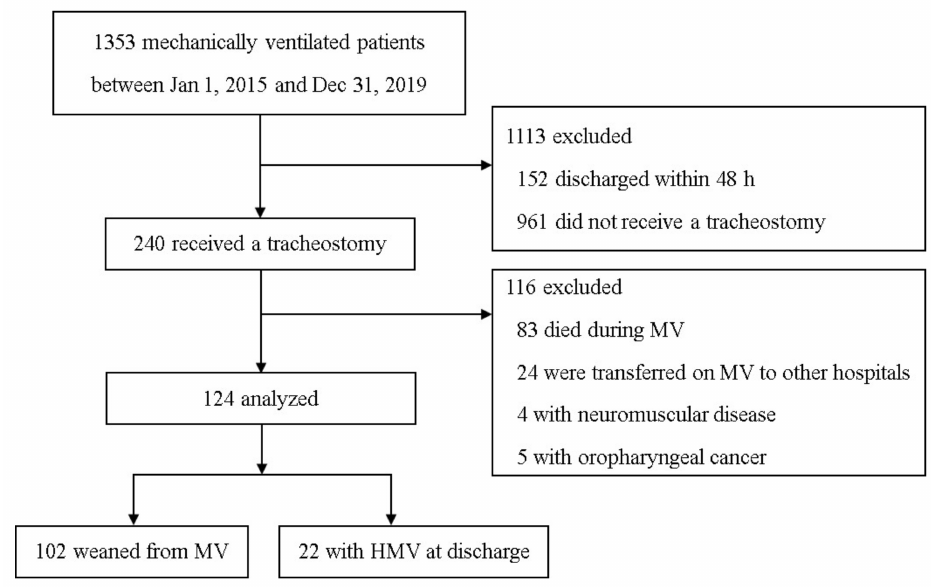
Figure 1. Patient flowchart. MV, mechanical ventilation; HMV, home mechanical